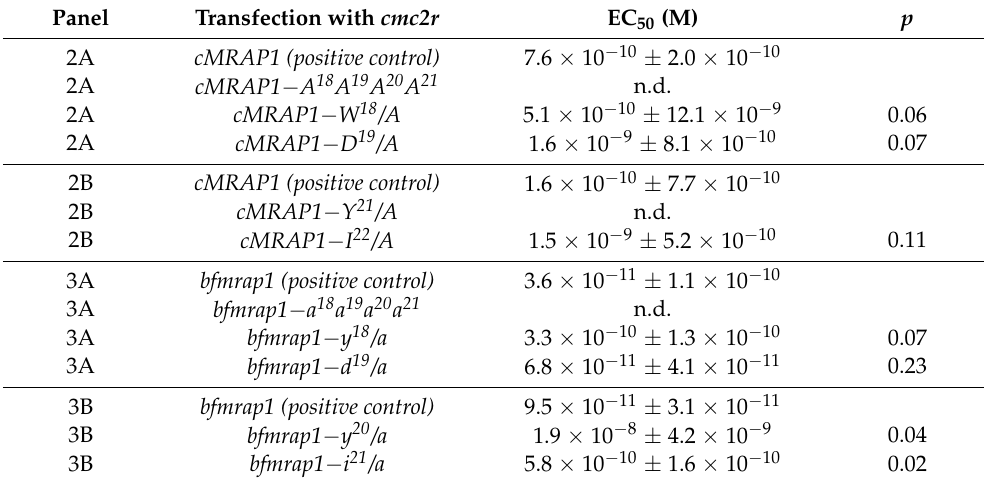
Table 1. Analysis of EC 50 values derived from the experiments presented in Figures 2 and 3. Panel